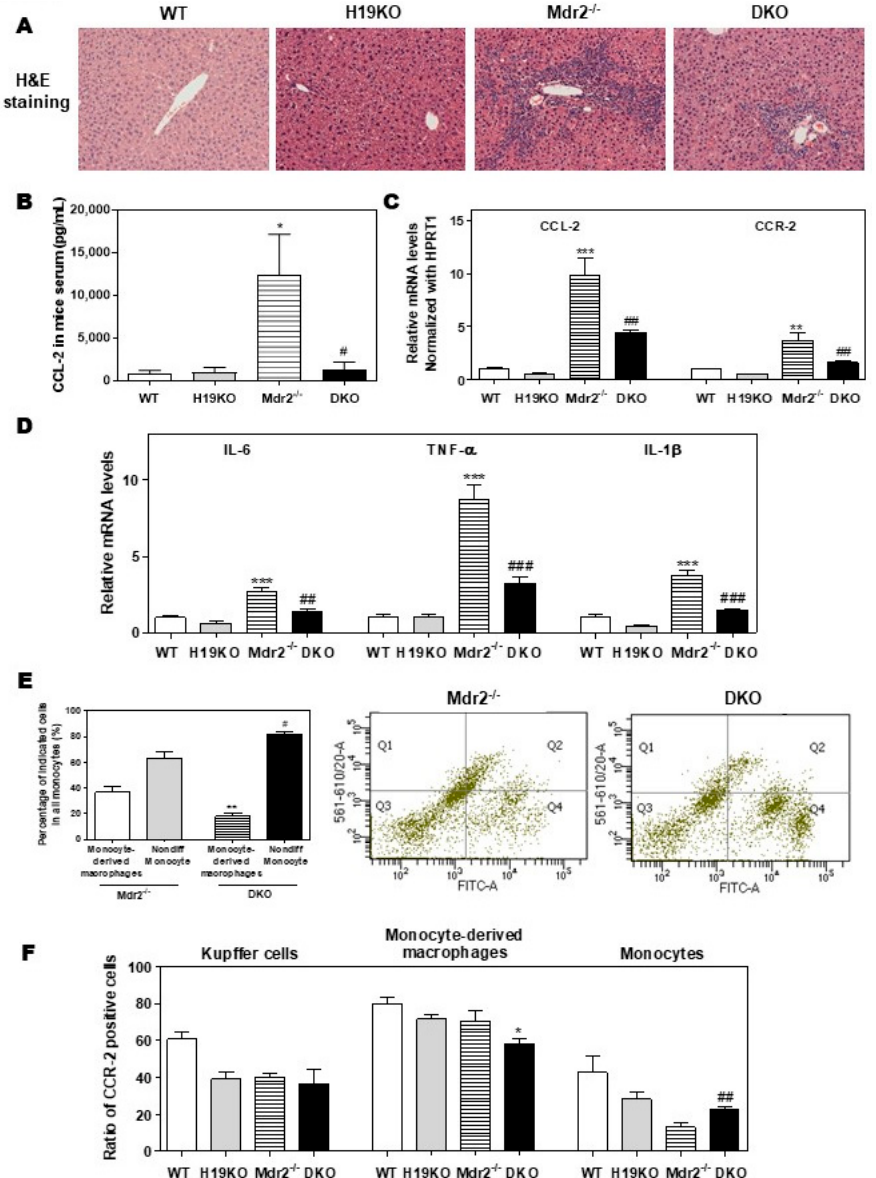
Figure 5. H19-enriched exosomes promote liver inflammation and macrophage activation in Mdr2 - / - mice. WT, H19KO, Mdr2 - / - mice, and DKO mice (both male and female at 100-day old) were sacrificed. ( A ) Representative images of H&E staining are shown. ( B ) CCL-2 levels in the serum. ( C , D ) The relative mRNA levels of hepatic CCL-2, CCR-2, IL-6, TNF- α , and IL-1 β were determined by real-time RT-PCR and normalized using HPRT1. Statistical significance: * p < 0.05, ** p < 0.01, *** p < 0.001, compared with WT mice; # p < 0.05, ## p < 0.01, ### p < 0.001, compared with Mdr2 - / - mice. ( E , F ) Cell type-specific markers were used to determine the cell population using flow cytometry analysis. ( E ) Representative flow cytometry results and images of the percentage of indicated cells in all monocytes are shown. ( F ) The ratio of CCR-2 (C-C chemokine receptor 2) positive cells in Kupffer cells, monocyte-derived macrophages, and monocytes. Statistical significance: * p < 0.05, ** p < 0.01, compared with monocyte-derived macrophages in Mdr2 -/- mice; # p < 0.05, ## p < 0.01, compared with non-differentiated monocytes in Mdr2 -/- mice ( n > 6).